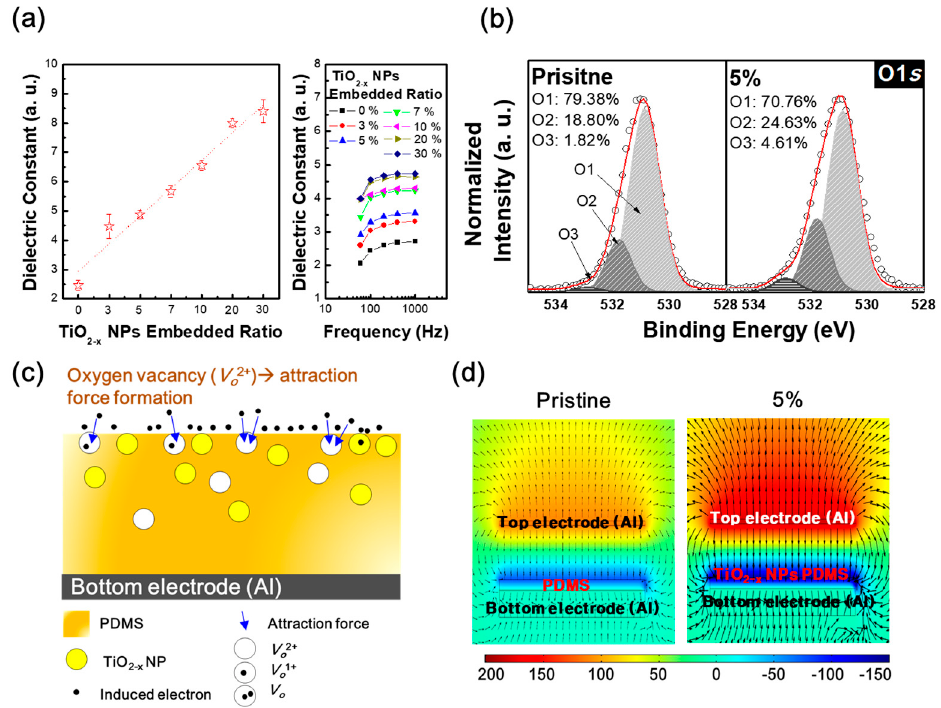
Figure 3. ( a ) Dielectric constant of the TiO 2 − x NPs embedded PDMS layers according to the frequency with different TiO 2 − x NPs weight ratios; ( b ) De-convoluted X-ray photoelectron spectroscopy (XPS) spectra of oxygen (O) 1 s states of pristine PDMS layer and TiO 2 − x NPs 5% embedded PDMS